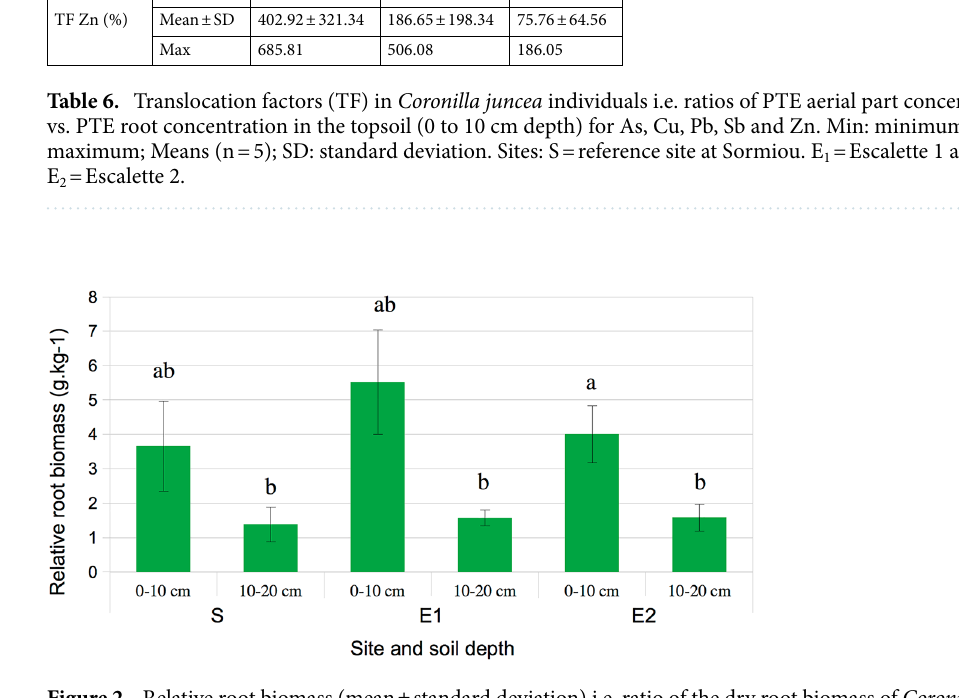
Figure 2. Relative root biomass (mean ± standard deviation) i.e. ratio of the dry root biomass of Coronilla juncea vs. dry soil mass at different soil depths and sites. Means are expressed in gram of dry roots per kg of dry soil. Different letters indicate a significant difference between means (p-value ≤ 0.05). Sites: S = reference site at Sormiou. E 1 = Escalette 1 and E 2 = Escalette